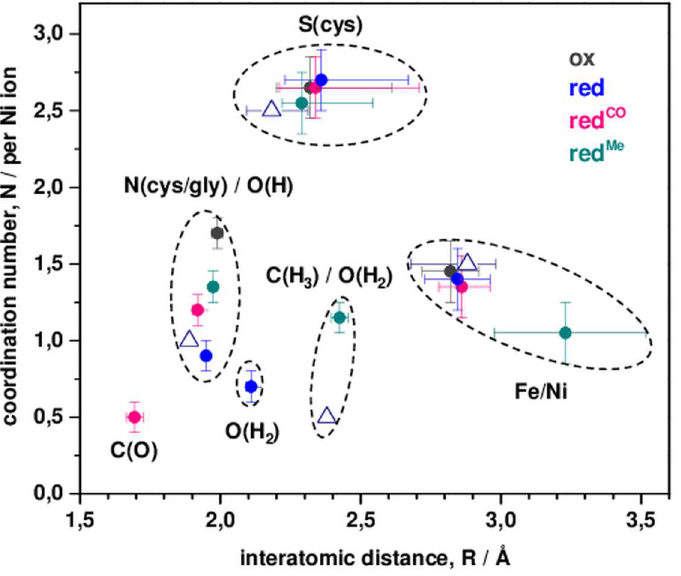
Fig 4. Nickel coordination changes from EXAFS. Mean R -values(weightedby the coordinationnumbers) and (summed) N -valuesfor NMC and C variants (Table 2) are shown for ox, ox CO , and ox Me samples. x-error bars show full distancerangesfor Ni-S and Ni-Ni/Fe shells or estimated EXAFS fit errors for the other shells; y-error bars show the estimated maximal fit error. Assignmentof parameters to C(O), O(H), O(H 2 ), and C(H 3 ) ligandsis tentative but plausible;see Fig 1 for N/S ligandsfrom amino acid groups. Open triangles, data for crystal structure 1RU3 [15] of oxidizedACS Ch (the long Ni p -O distanceof ~2.74 Å was omitted; the triangleat a distanceof ~2.4 Å corresponds to the Ni-ligand bond in structure 1OAO [17]).